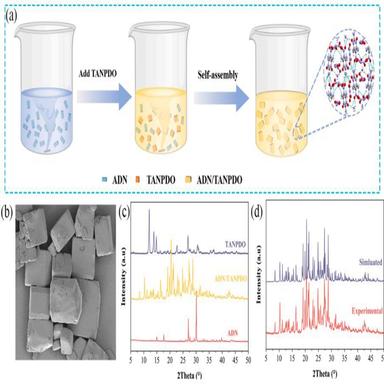
(a) The assembly process of ADN/ TANPDO supramolecular crystal. (b) The SEM image of ADN/ TANPDO supramolecular crystal. (c) The PXRD patterns of ADN/TANPDO supramolecular crystal, ADN, and TANPDO. (d) The experimental and simulated PXRD patterns of ADN/TANPDO supramolecular crystal.